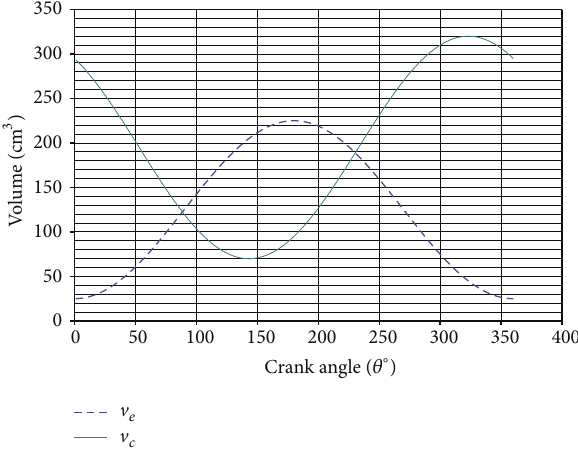
Figure 8: Relation for volume changing of expansion and contrac- tion space versus crank angle.